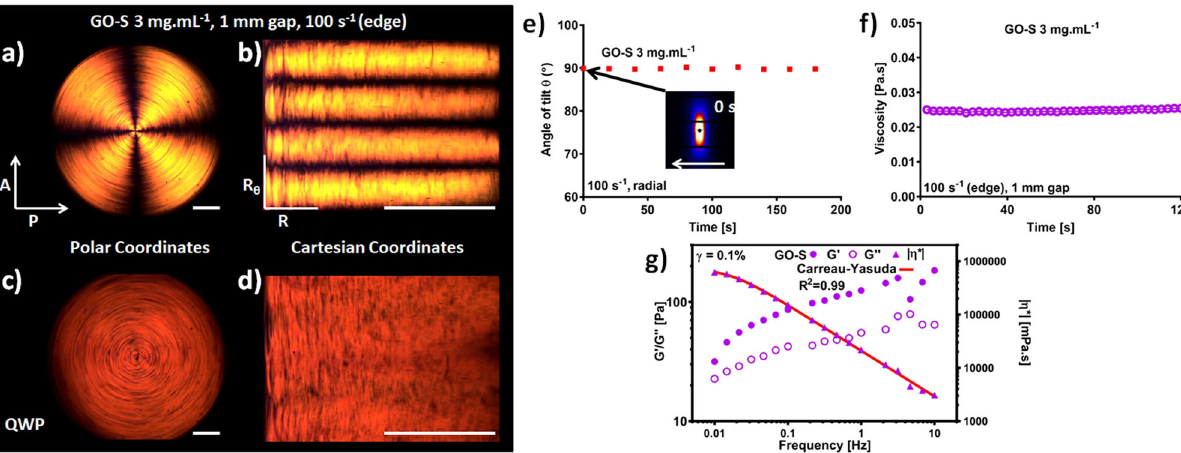
Fig. 5 Different behavior with smaller GO fl akes. a PLI of GO-S, as obtained, in polar coordinates. Diameter of the polarized light image is 25 mm. P and A de fi ne directions of polarizer and analyzer plane. b Transformed image of GO-S in Cartesian coordinate system. The two-line plots R θ — tangential and R — radial show directions at which two different features could be observed: Maltese cross in the R θ direction and apparent vorticity shear bands in the R direction. c Quarter wave plate (QWP) SIPLI of 3 mg mL − 1 GO-S with the shear rate at the edge of 100 s − 1 . d Transformed QWP image of GO-S in Cartesian coordinates. Scale bar on SIPLIs depicts 5.86 mm. e Orientation angle of 3 mg mL − 1 GO-S sheared in coaxial cylinder geometry at ω = 4.17 rad s − 1 with a 1 mm gap, in the radial direction, as a function of time taken during the shear experiment. Initial 2D SAXS pattern obtained for GO-S is embedded in the graph. Direction of shear is depicted on the 2D pattern by the white arrow. f Time sweep parallel-plate rheology of GO-S at 3 mg mL − 1 ( ω = 8 rad s − 1 , edge shear rate of 100 s − 1 ). During the whole measurement, the viscosity was nearly constant and no rheopecty was observed. g Frequency sweep of GO-S performed using parallel-plate geometry in oscillatory mode (disc diameter 60 mm and a gap d = 0.5 mm). Red line represents the Carreau-Yasuda model fi tting using Eq.